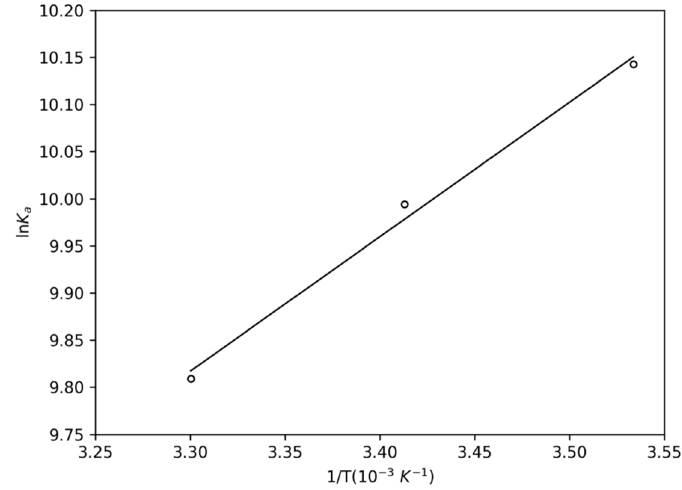
Figure 4. Van’t Hoff plot for the complex NBD-PPL at 283 K, 293 K, and 303 K.